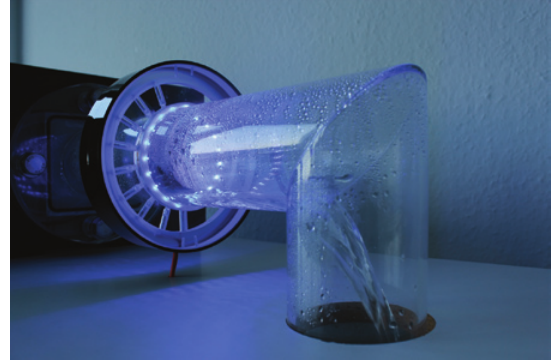
Figure 5: Demonstration plant: a hybrid system consisting of a composit microsieve and a UV-LED decontamination (nanoPur). © Fraunhofer